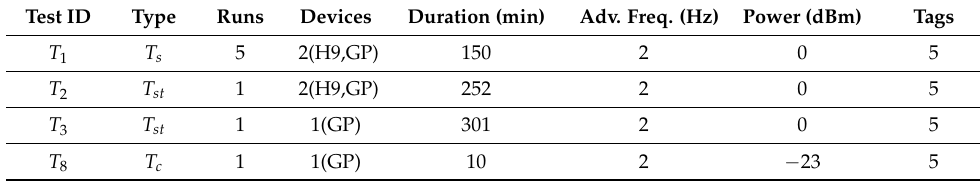
Table 3. Overview of the experimental data collection